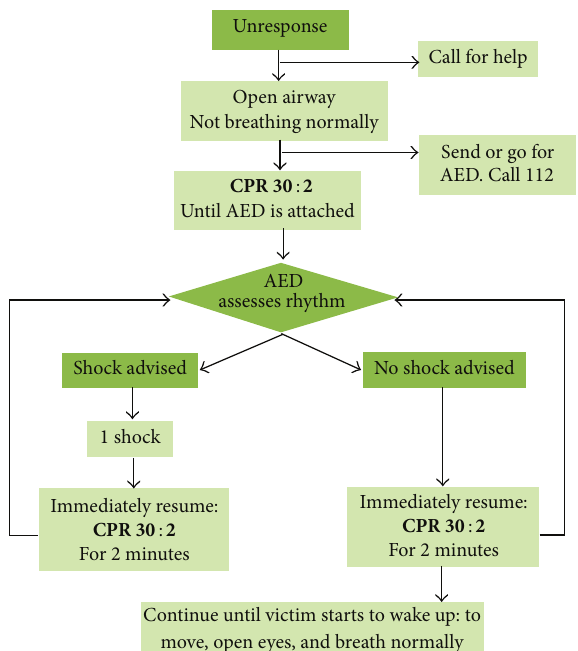
Figure 1: Automated external defibrillator algorithm according to 2010 ERC